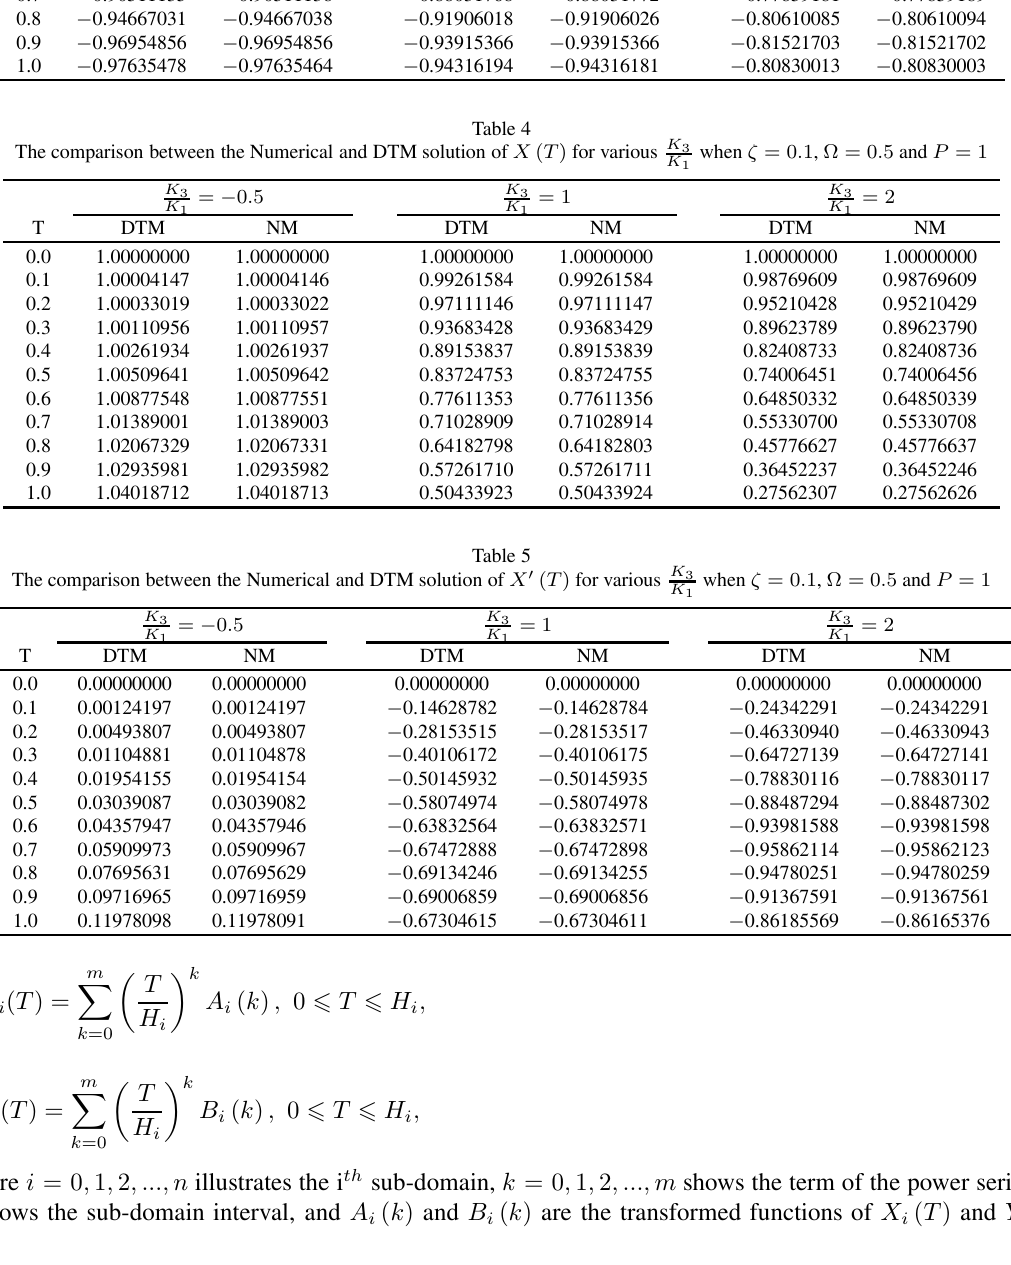
The comparison between the Numerical and DTM solution of X (cid:3) ( T ) for various P when ζ = 0 . 1 , Ω = 0 . 5 and K 3 K